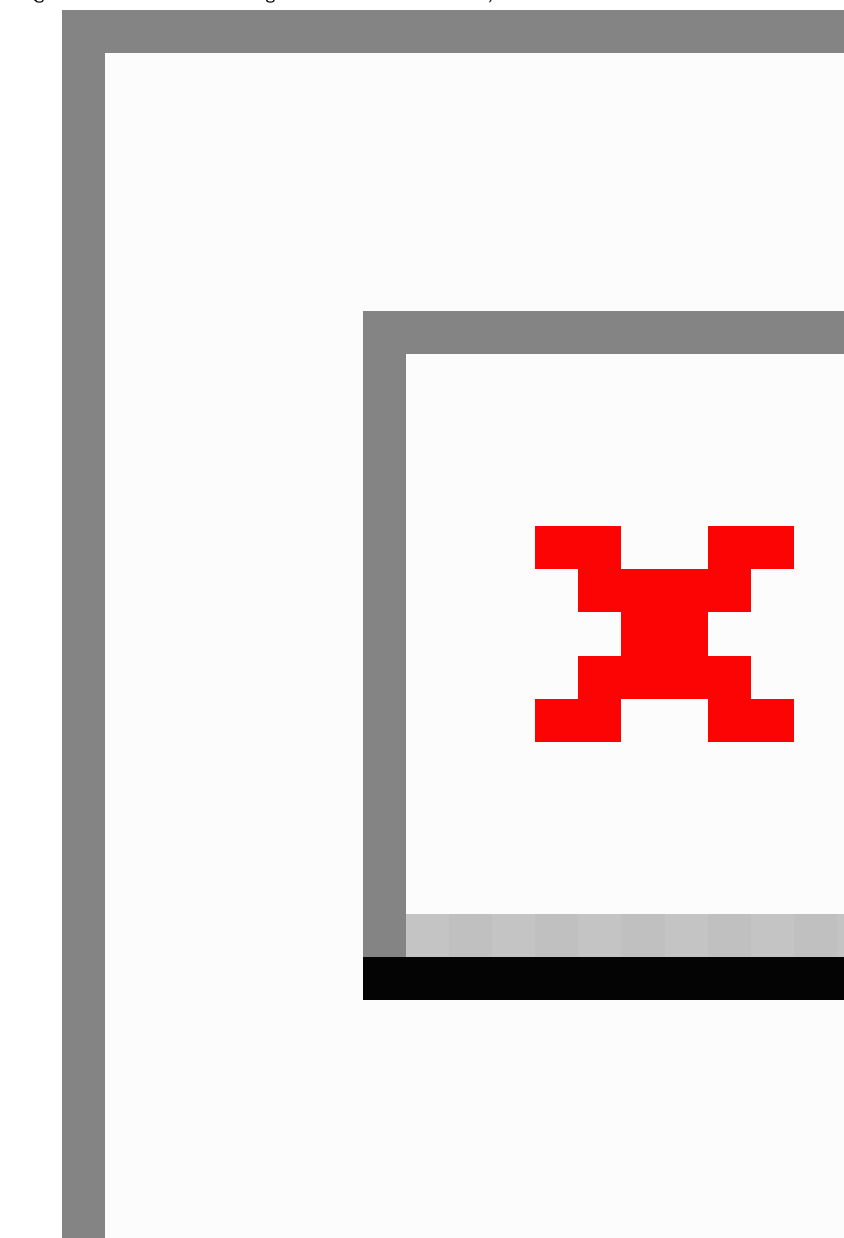
Figure 2. Monitoring key nutrients by the app. Nutrients are divided into three groups: (1) carbohydrates, proteins, fats, (2) minerals, and (3) vitamins (green bar – intake according to the recommendations, red bar – intake below the